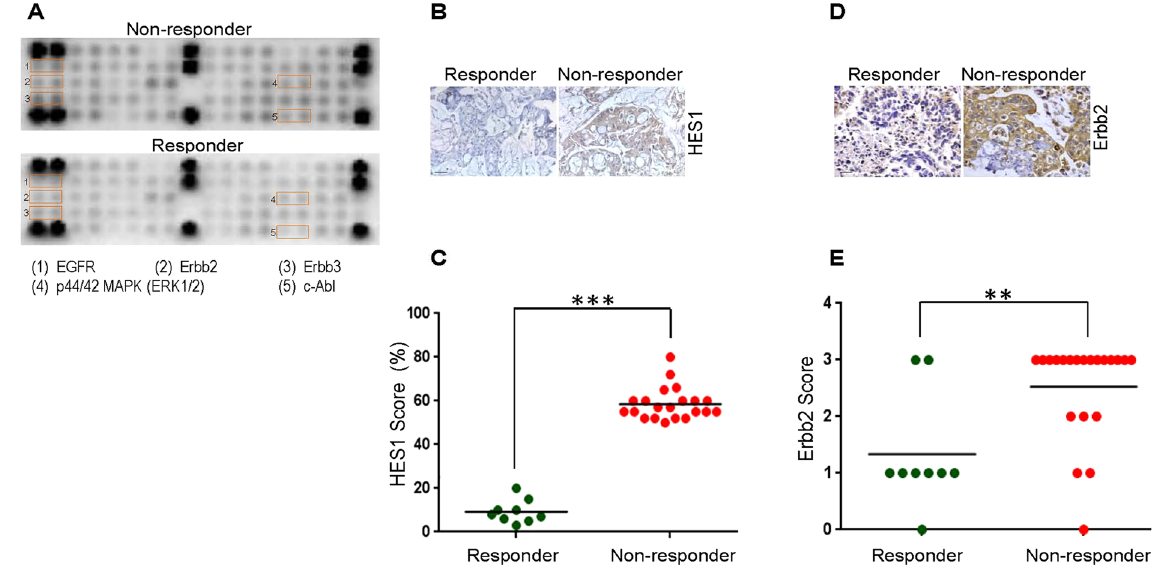
Figure 3. Validation of potential targets identified by transcriptomic analysis in the cohort non-responsive to cetuximab. ( A ) RPPA profiling for multiple targets was performed using total proteins extracted from cetuximab-sensitive (bottom) and cetuximab-resistant (top) tumors at baseline. Spots are in duplicate and each pair corresponds to a specific RTK or signaling node as defined in the array map. The orange insert represents EGFR and associated pathways deregulated in non-responders relative to responders. ( B ) To evaluate the baseline expression of pathway specific markers in responder (left column) and non-responder (right column) tumor samples from mCRC, the formalin fixed and paraffin embedded sections were probed with antibody against HES1. Representative images were taken at 200X magnification. ( C) Scatter plot depicting HES1 levels in the responder ( n = 9) and non-responder ( n = 21) population. HES1 scoring was performed using IHC on a scale of 0 to 100% in each of the tumor sections and significance ( *** P < 0.001, n = 27) was calculated using